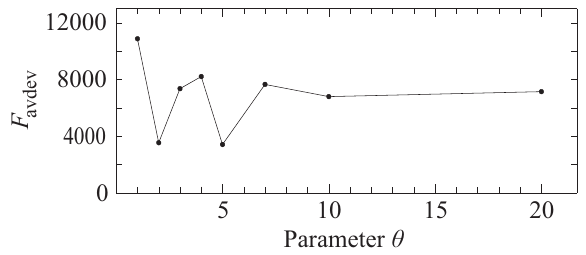
Figure 6. Average deviation F avdev versus parameter θ